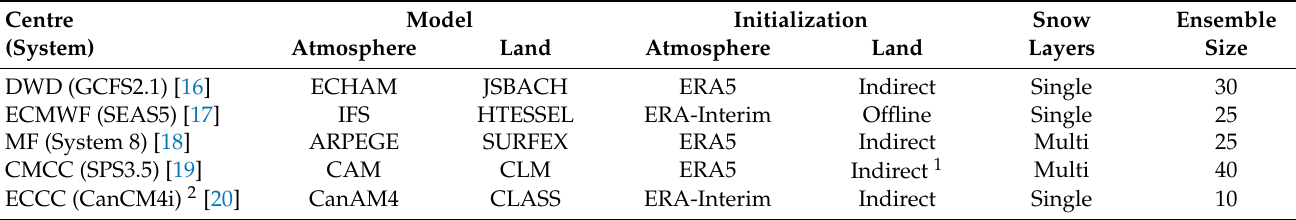
Table 1. Overview of some features and components of the five systems for their hindcasts.